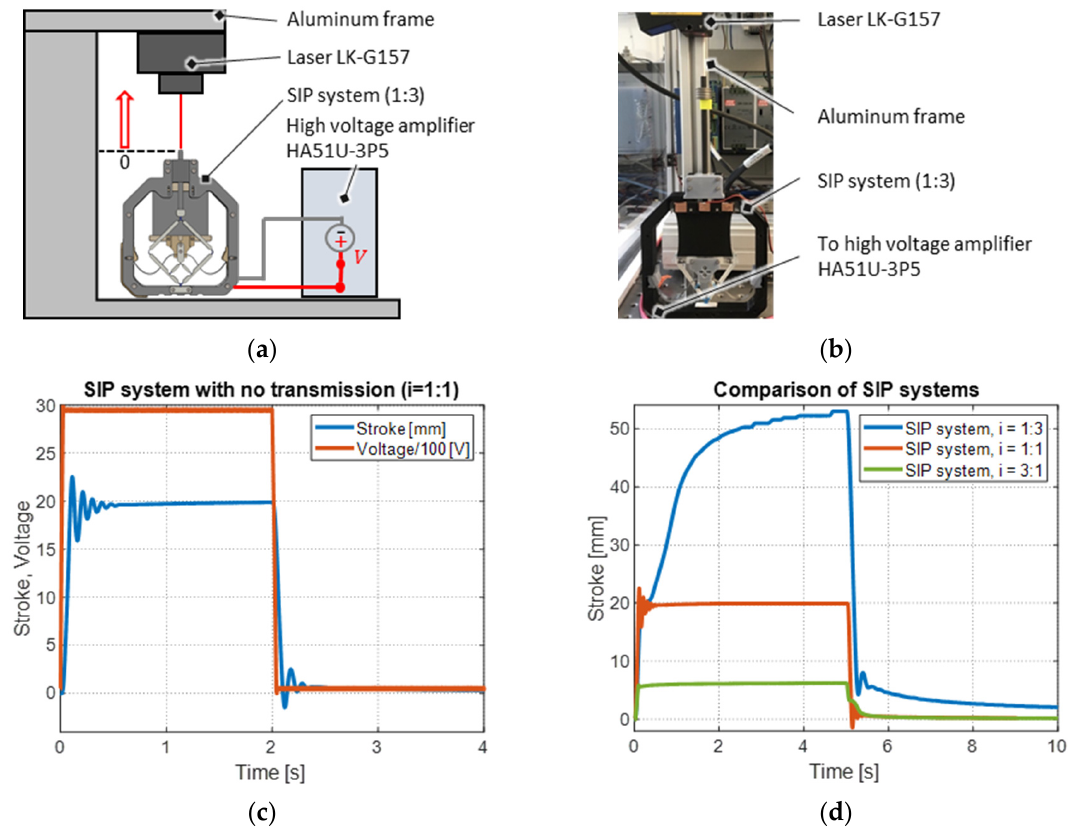
Figure 13. ( a ) Schematic illustration of the setup for characterization of the SIP system stroke with ( b ) corresponding photo, ( c ) measurement results for voltage and stroke of the SIP-NBS system with- out transmission mechanism, and ( d ) a comparison of the strokes of the different realized